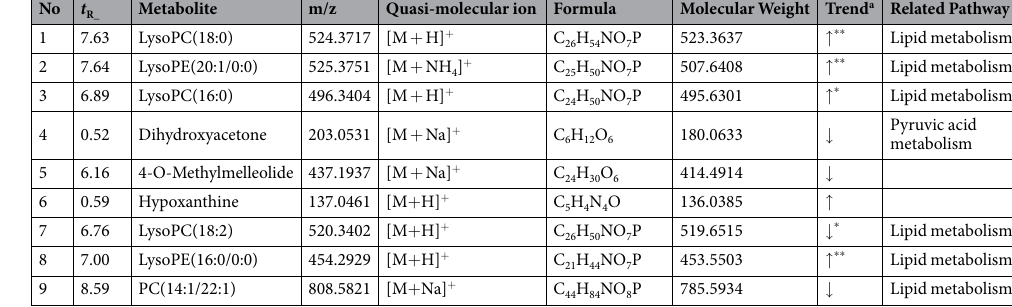
Table 2. 9 Biomarkers of resistant-ascites syndrome detected by ultra-performance liquid chromatography- quadruple time-of-flight high-sensitivity mass spectrometry (UPLC Q-TOF/MS) in positive ion mode on day 35. a Change trend of resistant vs susceptible. Levels of potential biomarkers were labelled with ( ↓ )